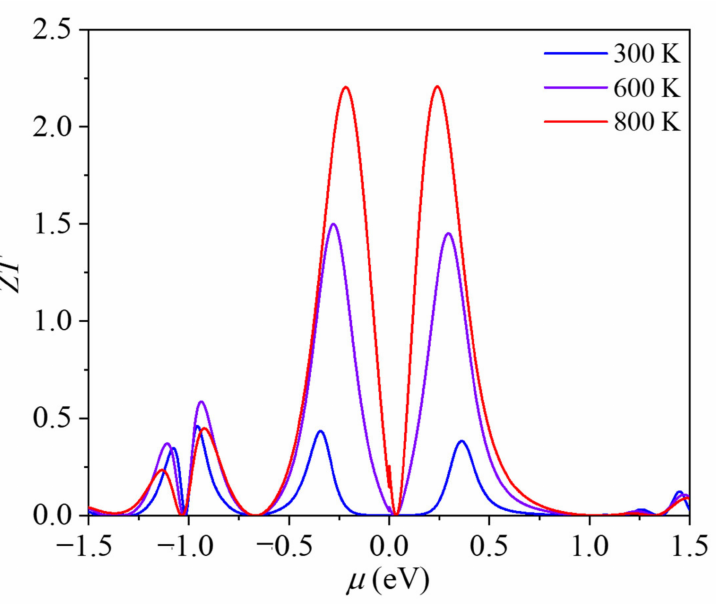
Figure 5. Variation in the thermoelectric figure of merit ( ZT ) of ID-GY with the chemical potential ( µ